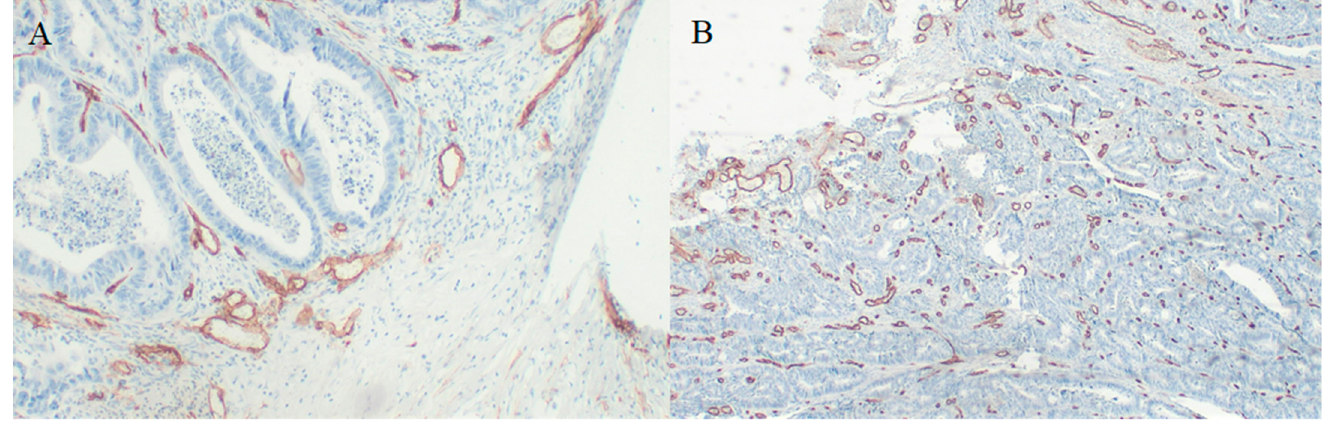
Figure 3. CD34 immunostaining in CRC specimens used to assess microvessel density (A) 400× magnification, (B) 100× magnification.